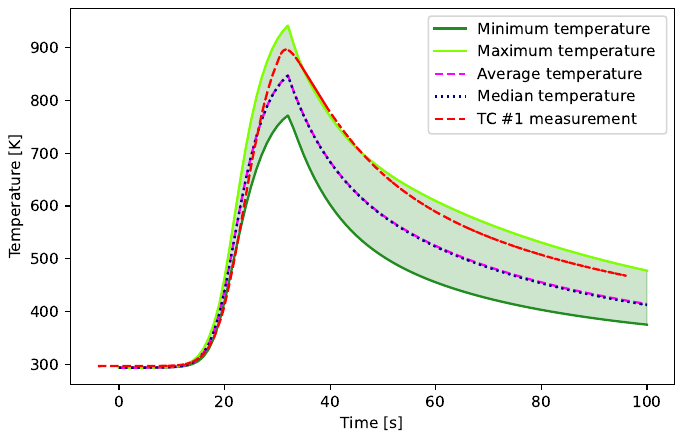
Figure 13. Results of the uncertainty quantification study for the temperature evolution of the fuel SIRIUS-CAL fuel specimen. The envelope of computed temperature trajectories is colored in green and the average and median temperature trajectories are presented. The temperature response of thermocouple #1 is shown in